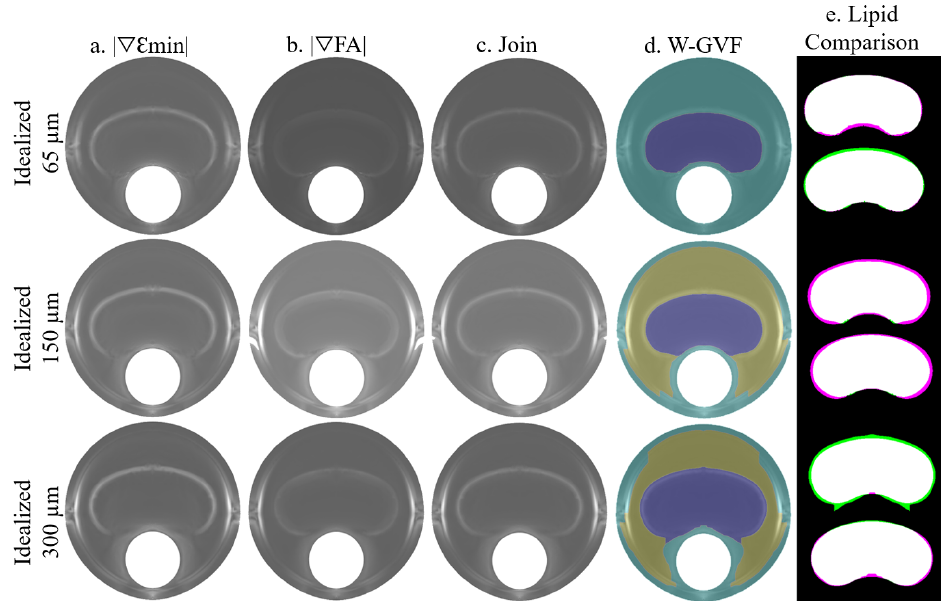
Figure 5. Influence of the FCT on the segmentation procedure analyzed with clean strains. The rows represent the segmentation process with the geometries of 65, 150, and 300 µ m of FCT. The segmentation process consists of the combination of two SGVs, in these cases |(cid:53) ε min | and |(cid:53) FA | in ( a , b ), respectively. The combination of both is represented in ( c ). This representation is the input for the W-GVF and its results are represented in ( d ); finally, the overlap between the actual and the segmented lipid core before and after the smooth treatment is represented in ( e ), where the true positive area is in white, the false negative area in green and the actual area that is not segmented in